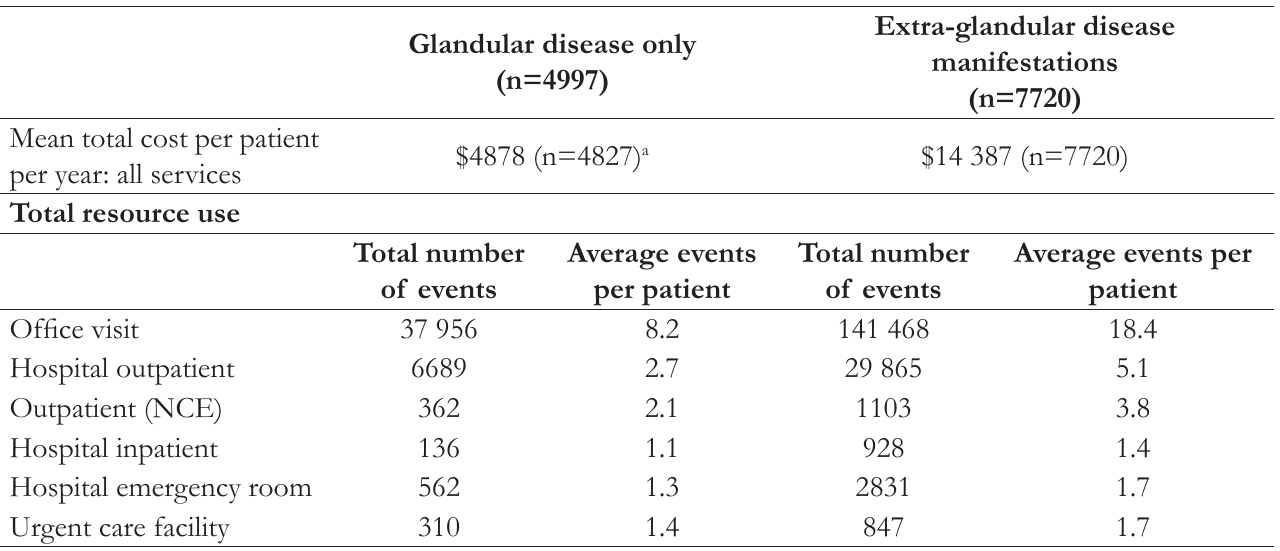
Table 1. Comparison of Healthcare Costs and Resource Use by Disease Characterization (Primary